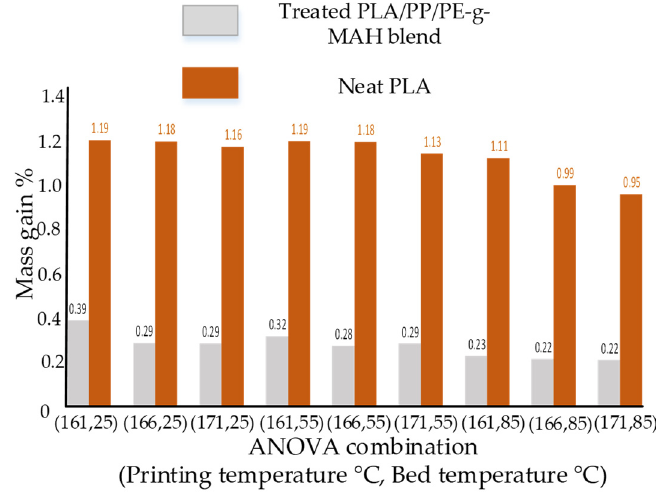
Figure 2. Mass gain percentage of water absorbed samples.